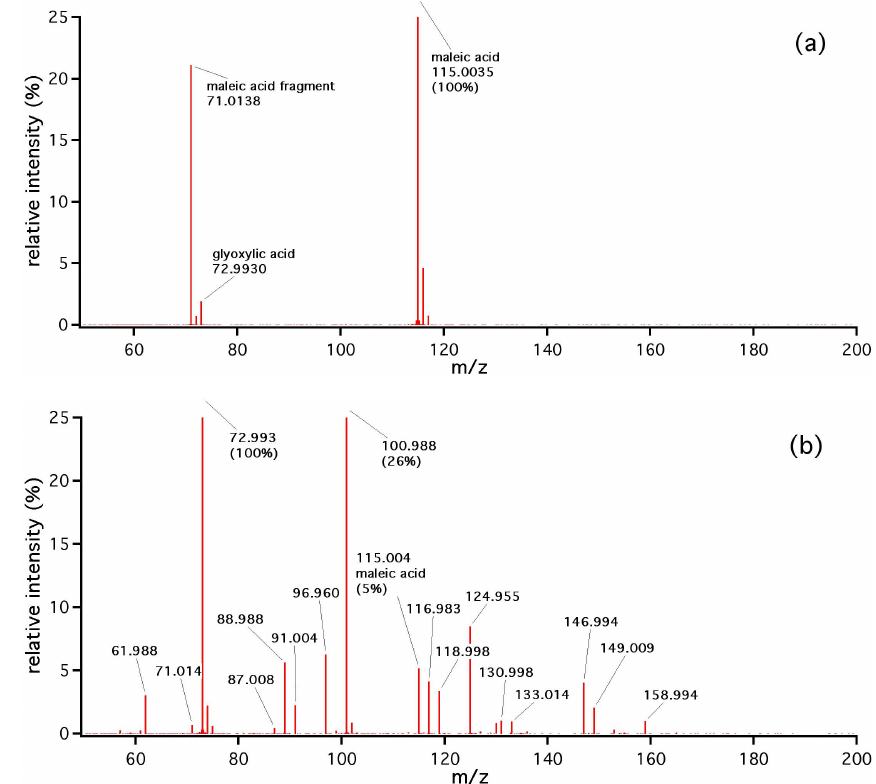
Fig. 3. Mass spectra of the reaction products of ozone and maleic acid particles reacted on a Teflon filter for 3h. The dry reaction was conducted at 10% RH (a) . The wet reaction was conducted at 80% RH (b) . Post reaction the processed particles were extracted with pure acetonitrile. Results of particles oxidized on the filter (Fig. 3) are comparable to results of the real aerosol experiments shown in Fig.